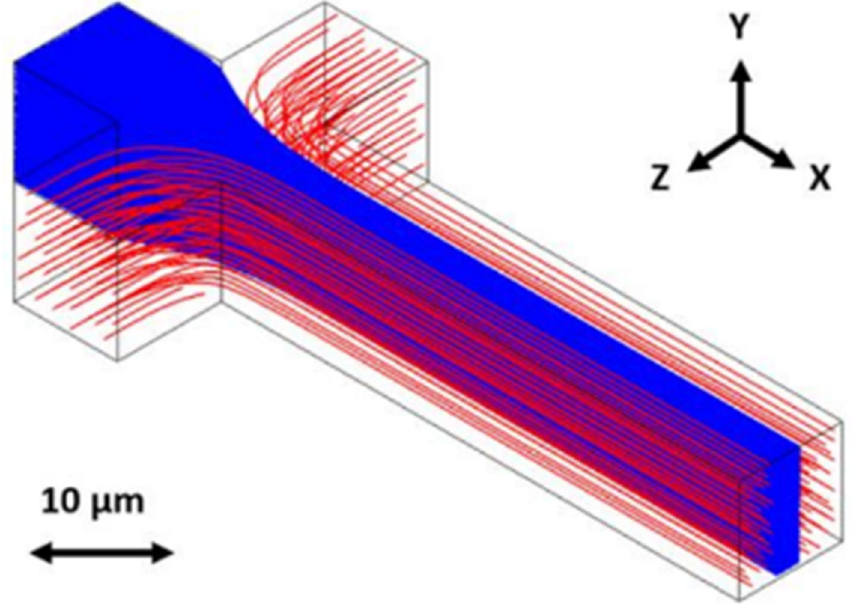
Figure 3. The use of side channels to create 2D focusing. This fi gure is cited from Hamilton et al. in